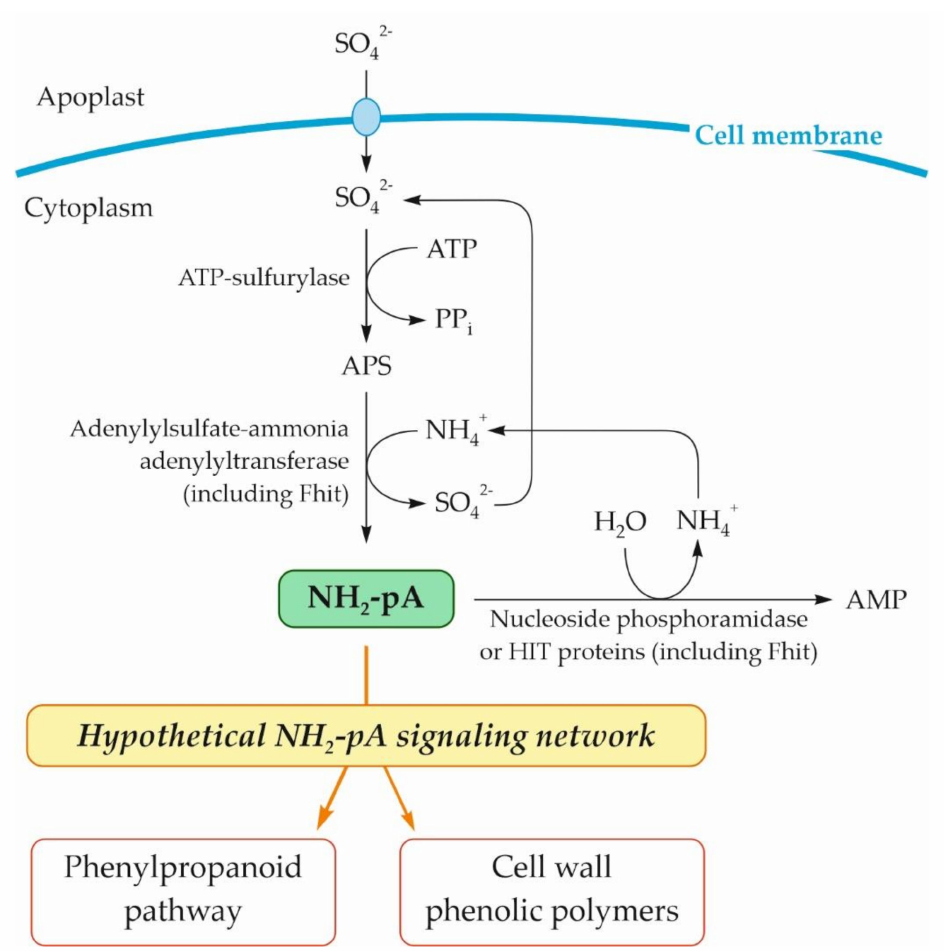
Figure 10. Schematic representation of metabolism of NH 2 -pA in plant cells and its effect on the phenylpropanoid pathway. APS, adenosine 5 (cid:48)